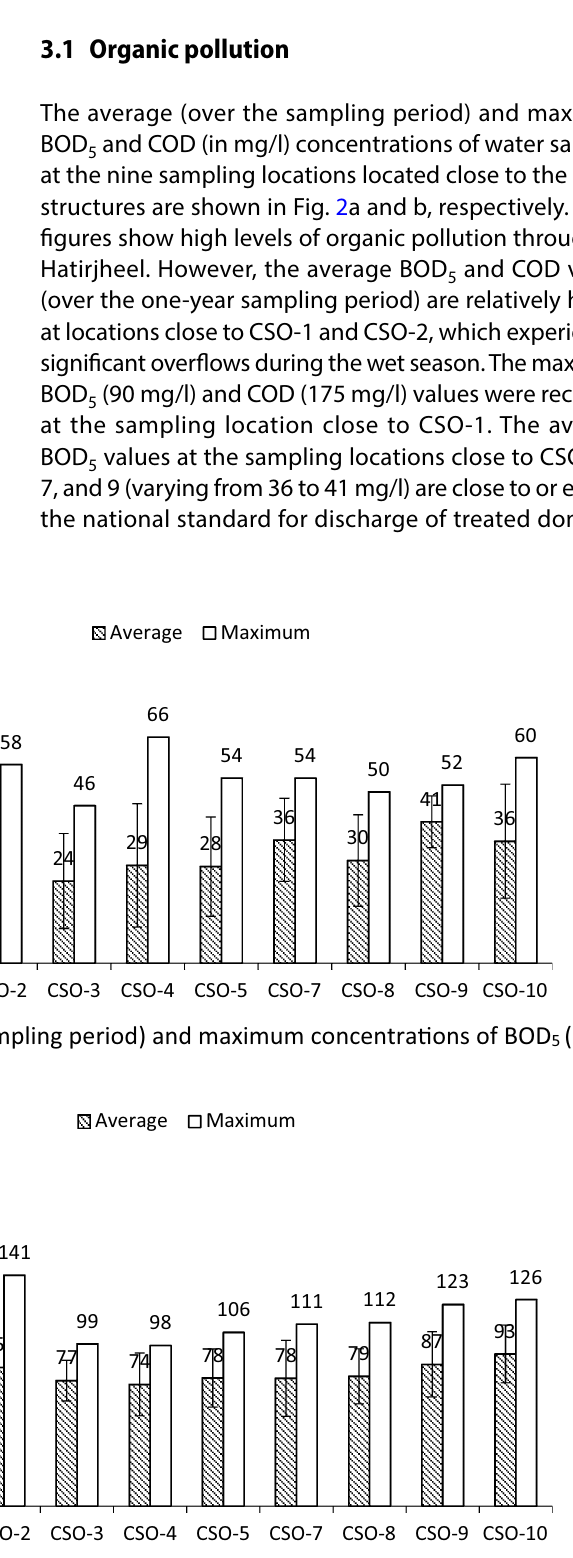
(b) Average (over the sampling period) and maximum concentra(cid:9)ons of COD